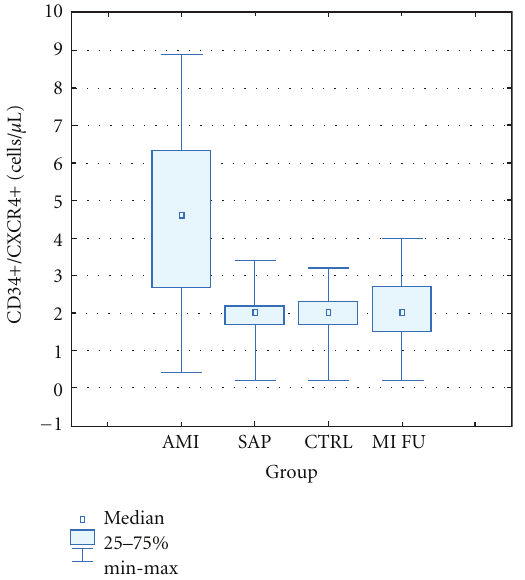
Figure 1: The number of circulating progenitor CD34+/CXCR4+ cells in peripheral blood. AMI: acute myocardial infarction, SAP: stable angina pectoris, CTRL: control group, MI FU: 1-year follow- up. Data is presented as cell number in 1 μ L of peripheral blood (median ± IQR). CD34+CXCR4+: CTRL 2,0 (0,2–3,4); SAP 2,1